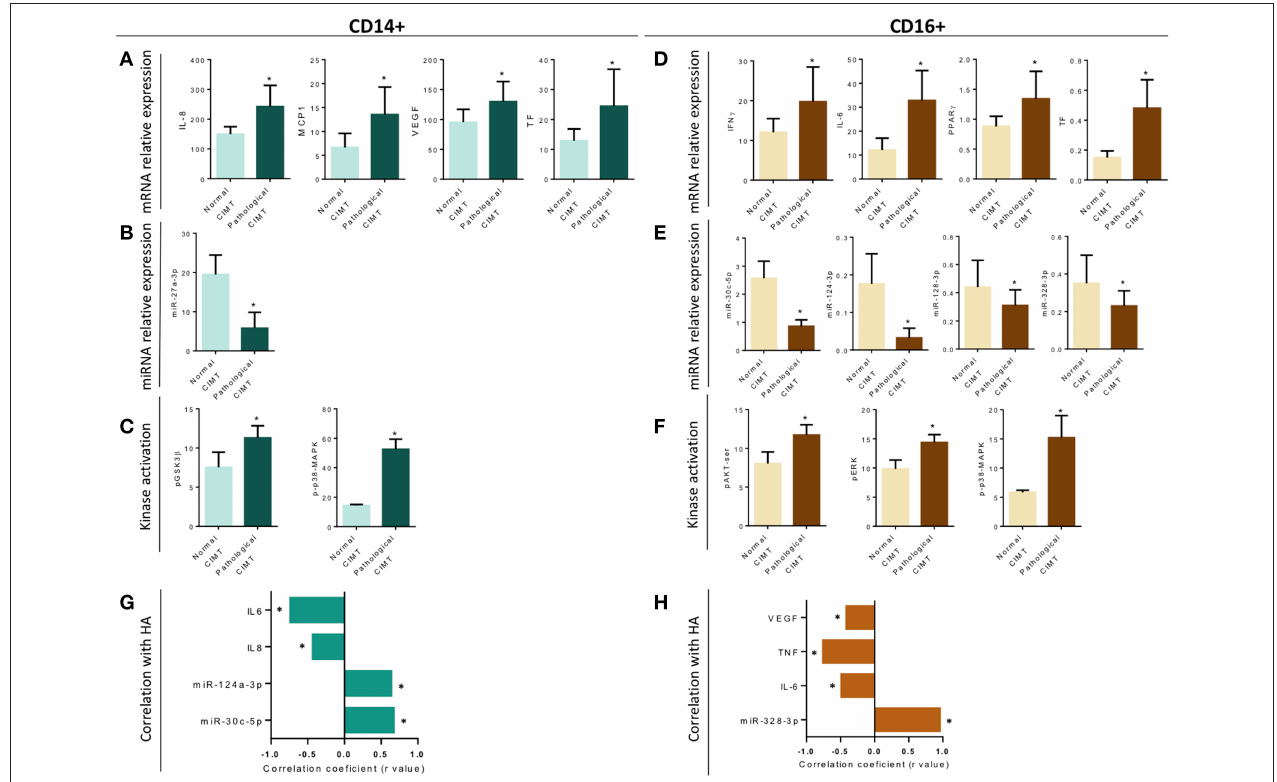
FIGURE 8 | Association and correlation studies among the distinctive molecular profile of CD14 + and CD16 + monocyte subsets of RA patients and the presence of early atherosclerosis or altered microvascular endothelial function. (A–F) Association studies among altered mRNAs, microRNAs and distinctive kinase activation in CD14 + and CD16 + monocytes and the presence of a pathologic carotid intima-media thickness (as early atherosclerosis marker). Data are expressed as mean and standard deviation. *indicates significant differences vs. normal CIMT ( p < 0.05). (G,H) Spearman’s rank correlations among monocyte subtype specific alterations in levels of miRNAs and microRNAs and reduced area of hyperemia after occlusion in RA patients, showing a p < 0,05 are indicated. Only significant correlations according to Bonferroni correction, are